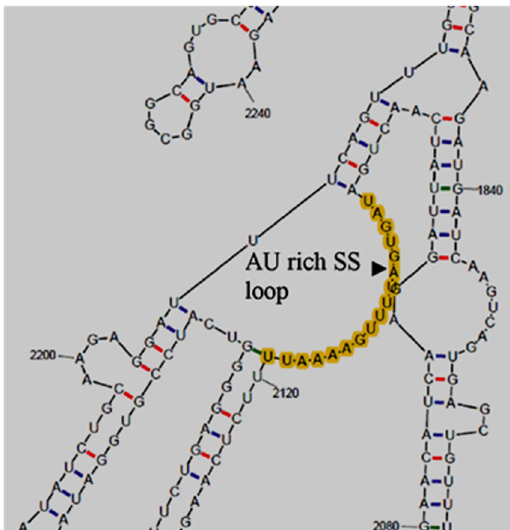
Figure 3. Part of the predicted secondary structure of chimeric ( malE + ACLSV MP ) RNA showing the single stranded (SS) AU rich loop spanning the region between nucleotides 2103–2119 (highlighted with yellow color) which is a potential site for cleavage by RNase E. The secondary structure was predicted at mFOLD web server (http://unafold.rna.albany.edu/?q = mfold/RNA-Folding-Form). This is a cropped image; full image is presented in supplementary Figure 1.